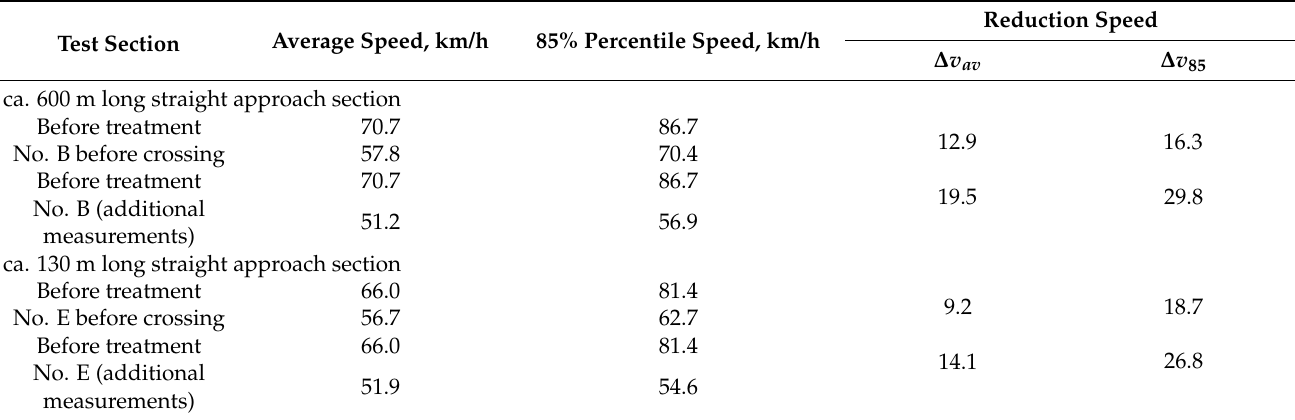
Table 2. Speed reductions before the pedestrian